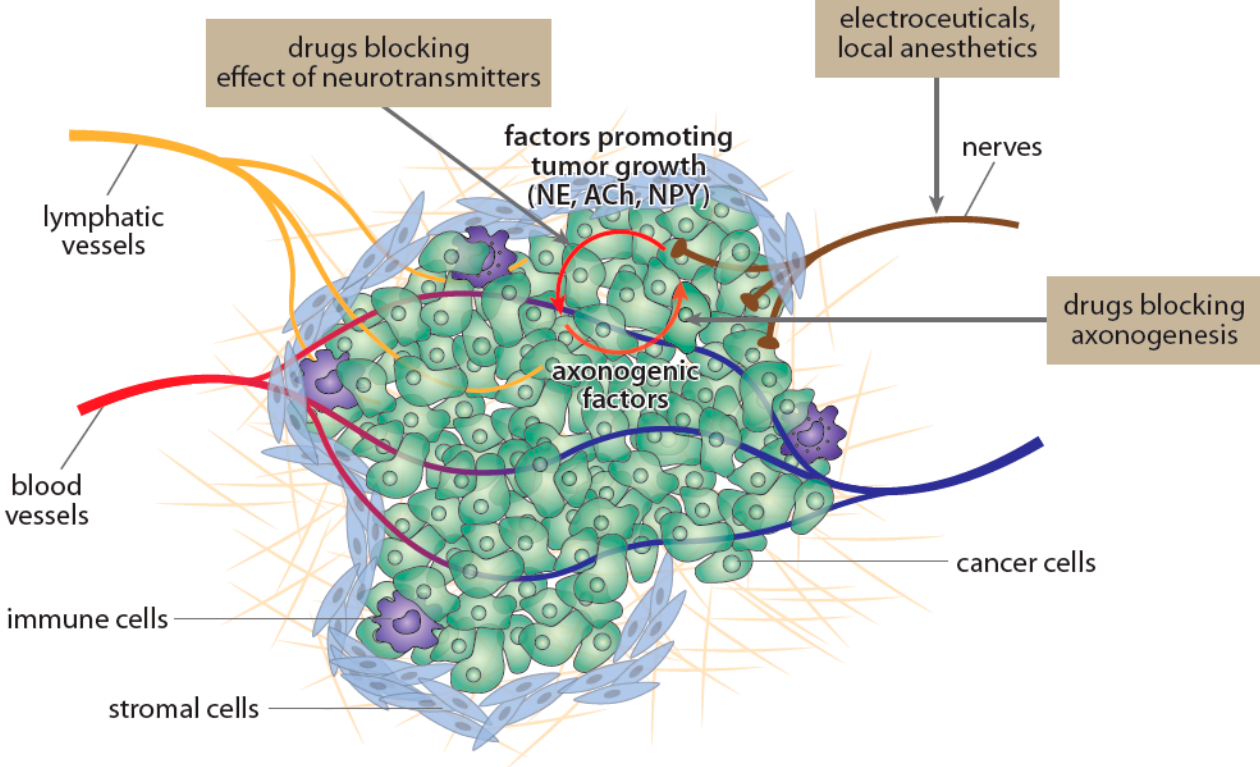
Figure 3. Schematic depiction of the vicious cycle created between nerves and cancer cells. Nerves innervating cancer tissue release neurotransmitters (e.g., acetylcholine (Ach), norepinephrine (NE), neuropeptide Y (NPY)) that stimulate tumor growth. The more cancer cells, the more released molecules, inducing the ingrowth of new axons (e.g., nerve growth factor, NGF). Therefore, administration of antibodies against NGF or suppression of the release of other molecules related to neoaxoneogenesis might be useful in reducing cancer growth. Modified according to Venkatesh and Monje [123].